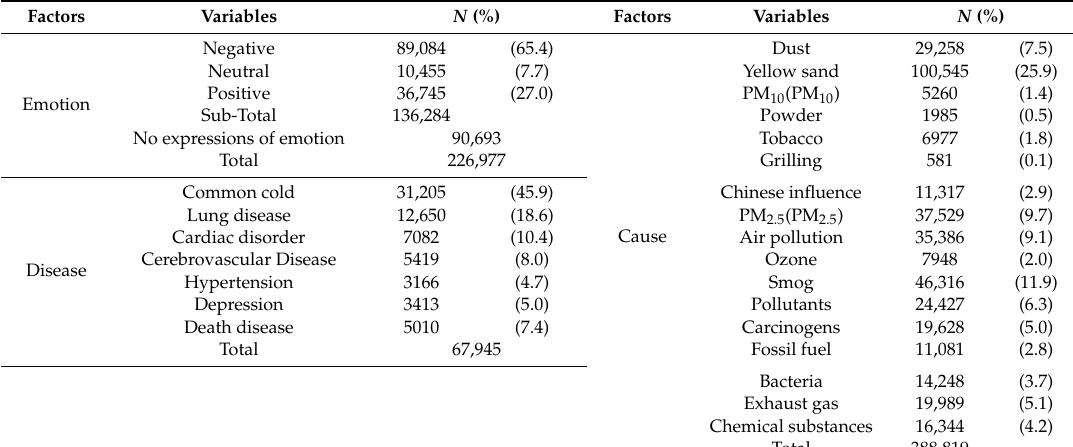
Table 1. Status of online documents related to particulate